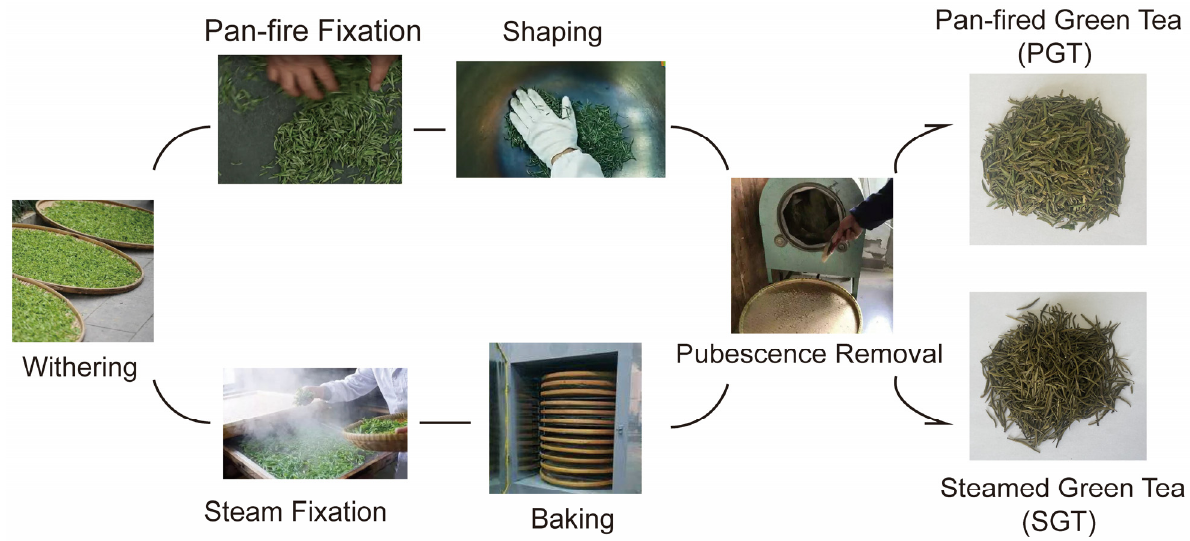
Figure 1. Manufacturing process of pan-fired green tea (PGT) and steamed green tea (SGT).